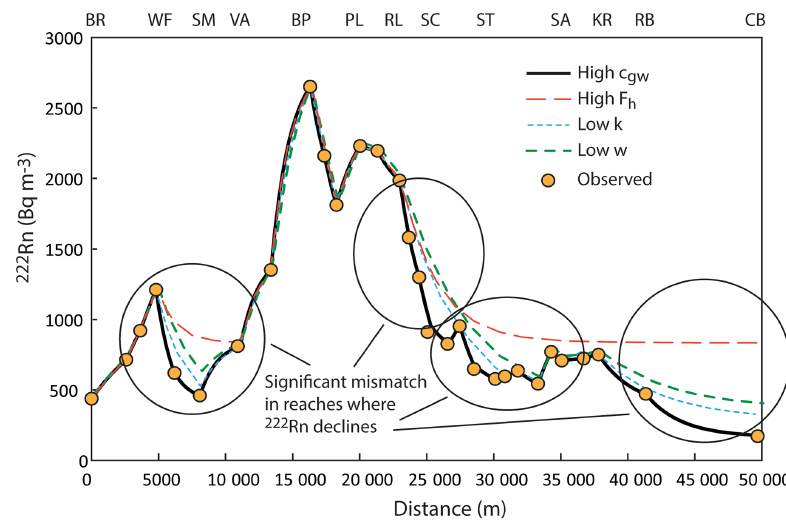
Figure 8. Calculated and observed 222 Rn activities for February 2015 resulting from varying individual parameters in Eq. (1). In all cases the new parameters result in significant overestimation of 222 Rn activities in many reaches and are unlikely to be realistic. Site abbreviations are as for Fig.